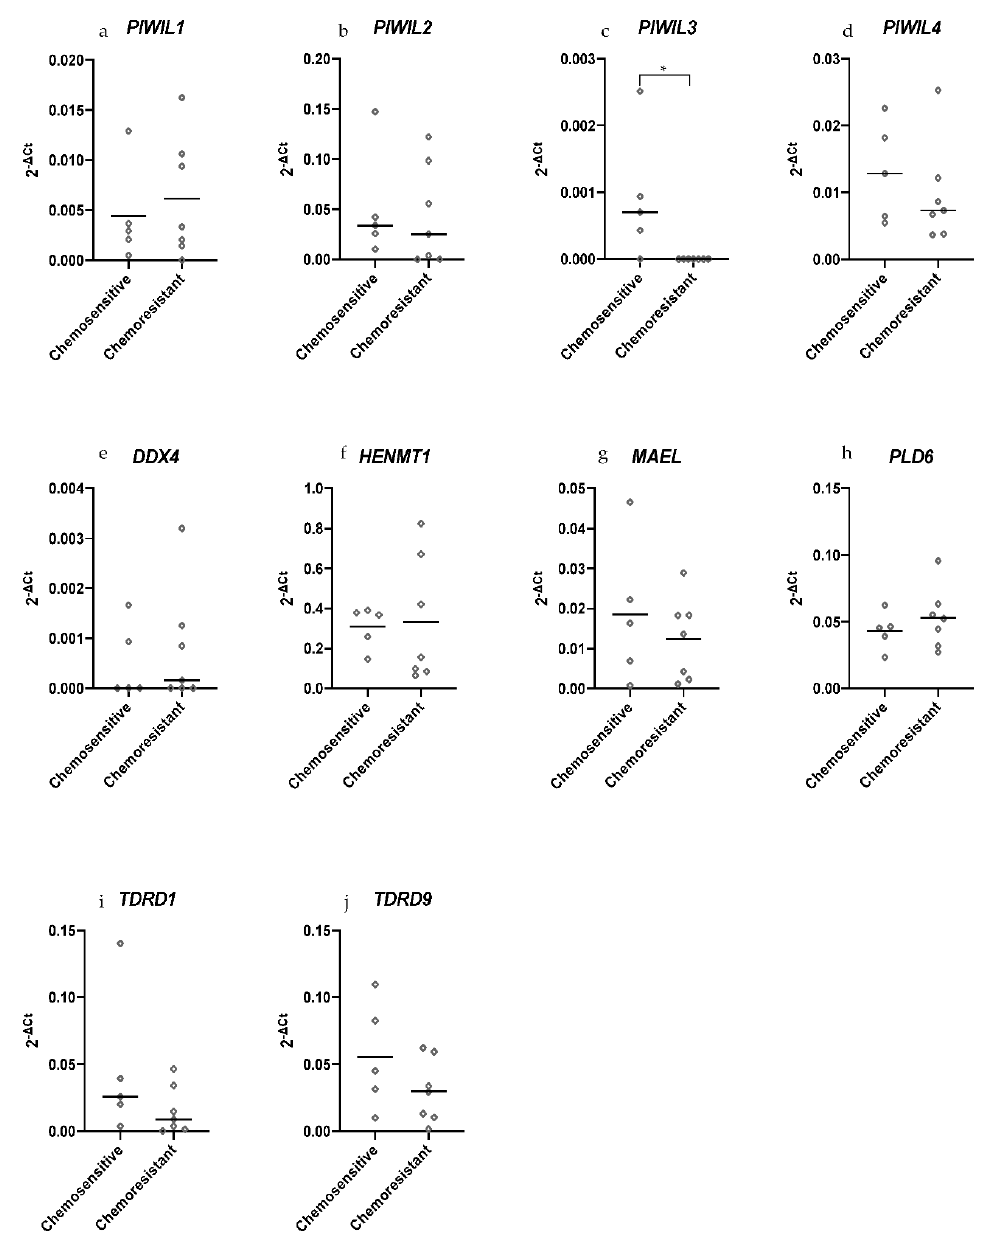
(Figure 6a). MAEL overexpressing OVCAR-3 and OV-90 cells displayed decreased cell motility (nonsignificant) compared to the empty vector control.